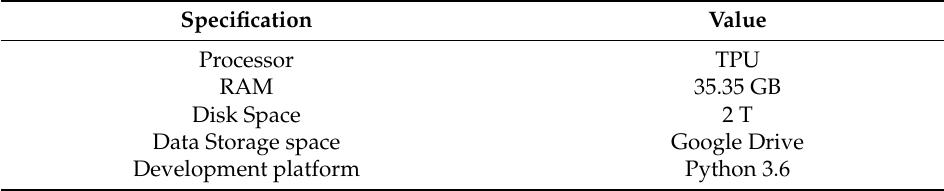
Table 2. Specifications of development environment.